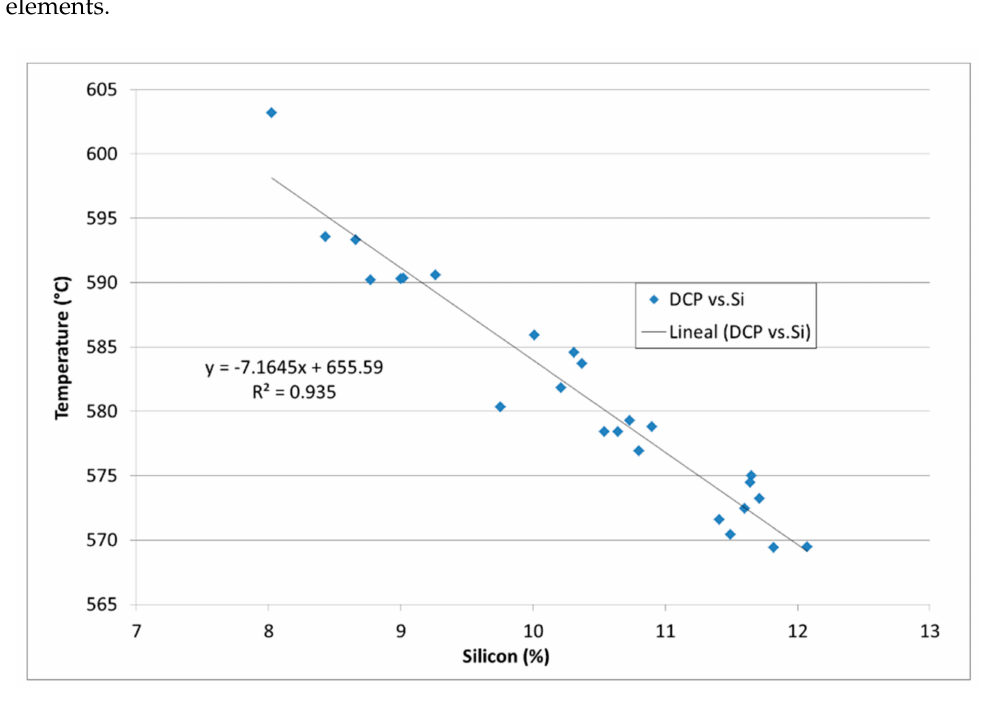
Figure 10. The effect of the Si percentage over the dendrite coherency point temperature with method